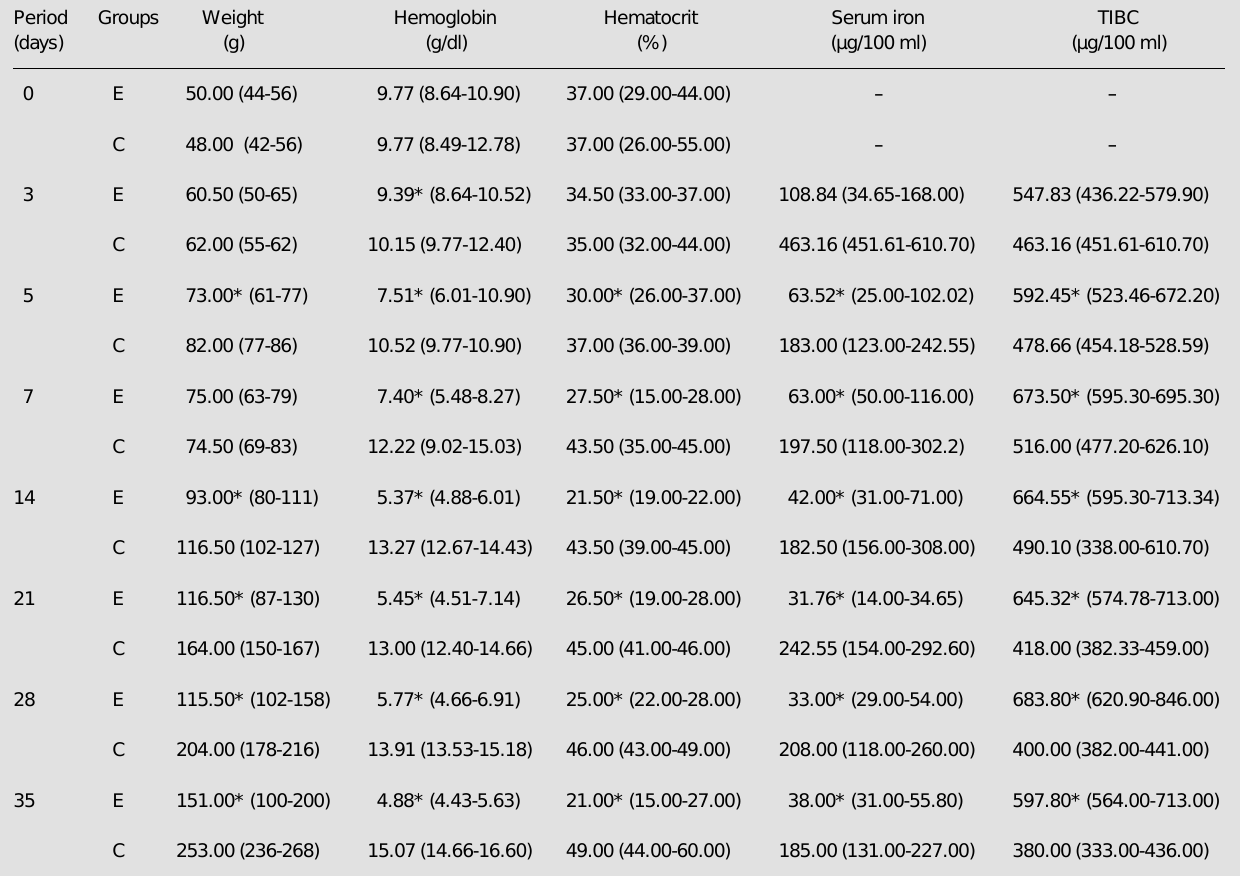
Table 1 - Median and range (between parentheses) of animal weight, hemoglobin and hematocrit, serum iron and total iron-binding capacity (TIBC) for the experimental (E) and control (C)